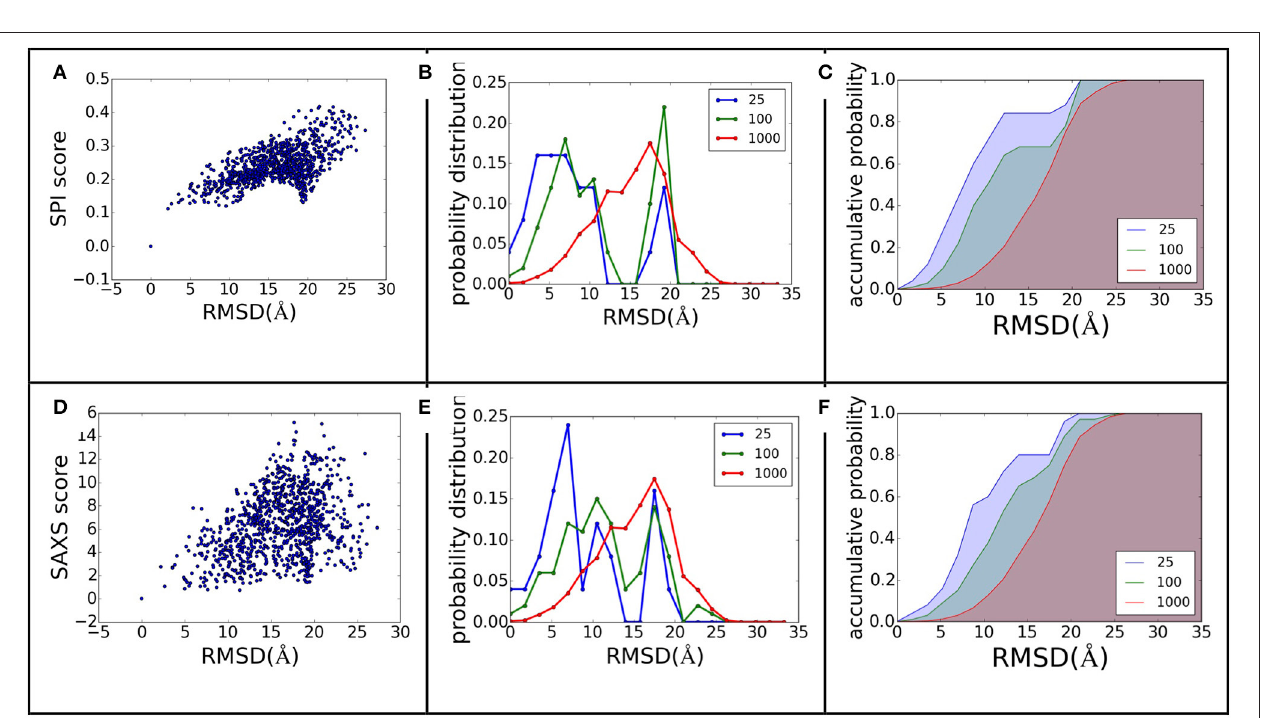
FIGURE 3 | The ranking power comparison between SPI-score and SAXS-score. (A,D) the scatter plot of scores as a function of RMSD. (B,E) the probability distribution function of RMSD for the selected models. The three curves correspond to the distribution function of top 25, top 100, and all models. (C,F) The accumulative probability functions corresponding to the three distributions in (B,E) . The green and blue shaded area indicates the gain of ranking power by selecting subsets of models.